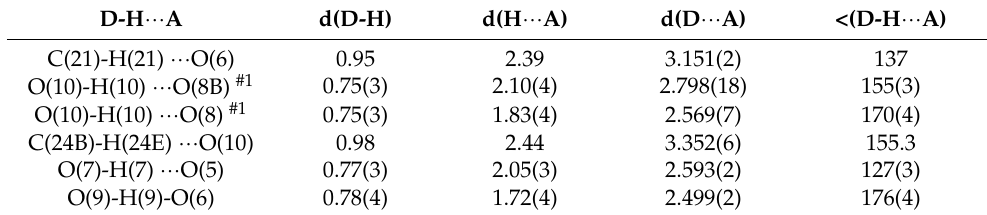
Figure 3. Hydrogen bond contacts (left), and view of the hydrogen bond packing scheme (right) of part A (upper). Table 3. Hydrogen bond parameters (Å, ◦ ) in the [Ag(Et3qu) 2 (citrate)]